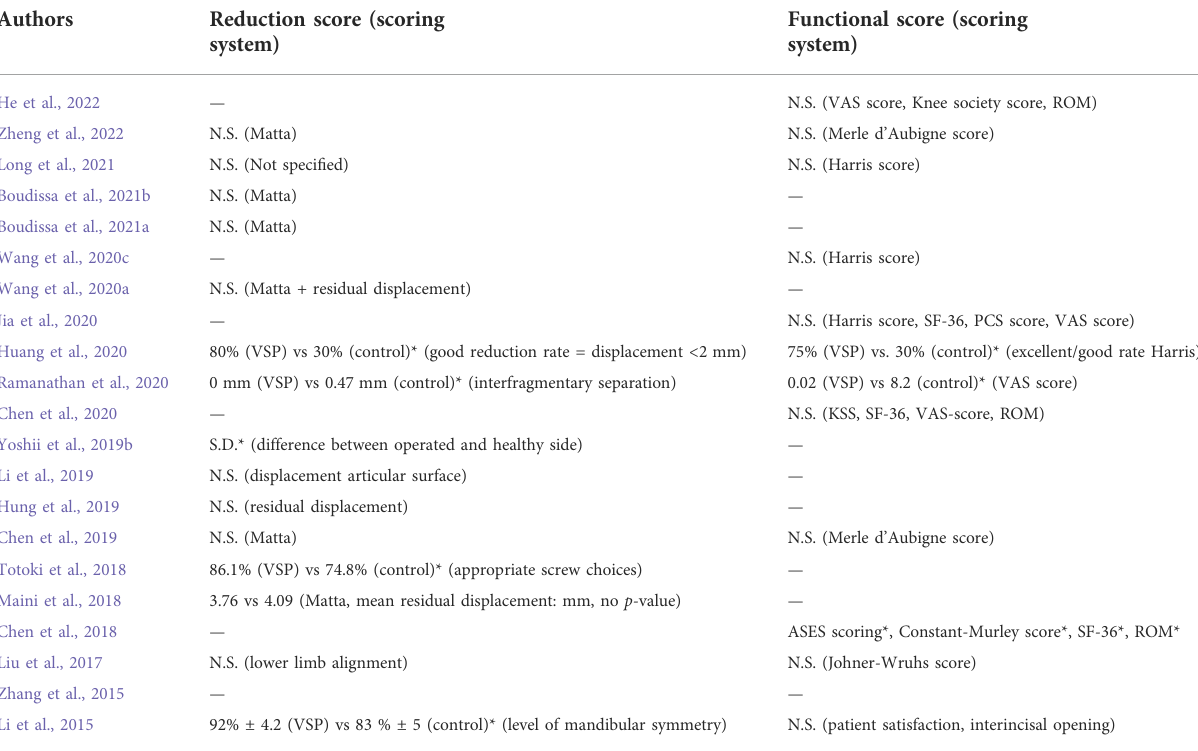
TABLE 5 Reduction quality difference and functional score difference reported in included studies. -: Not reported. N.S: not statistically signi fi cant. S.D*/*: statistically signi fi cant